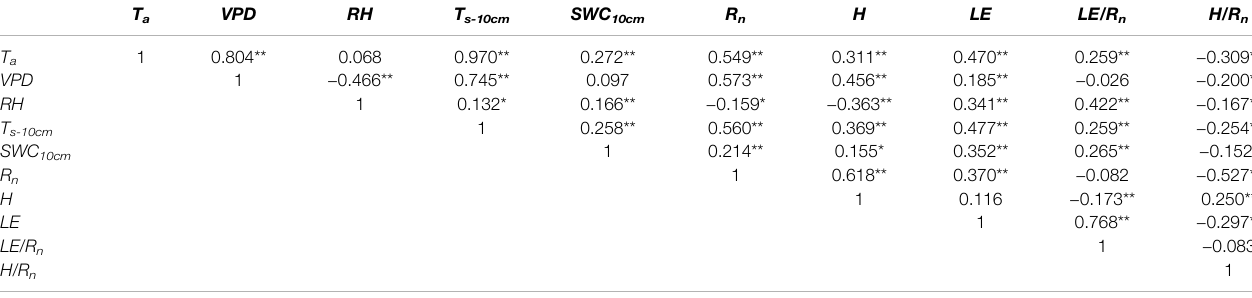
TABLE 4 | Correlation between energy fl ux and environmental factors in the same periods.